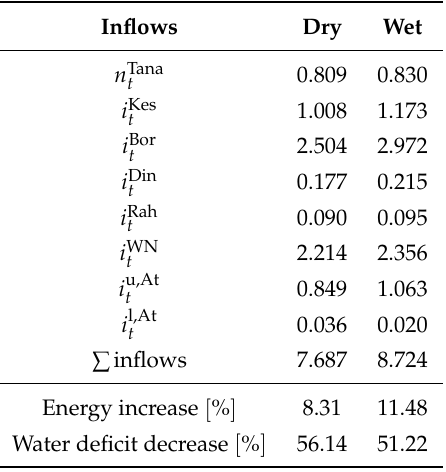
Table 1. Yearly average of inflows (km 3 /month) and objectives improvement with respect to the trivial policy, obtained using the optimal open-loop control sequence for two synthetic